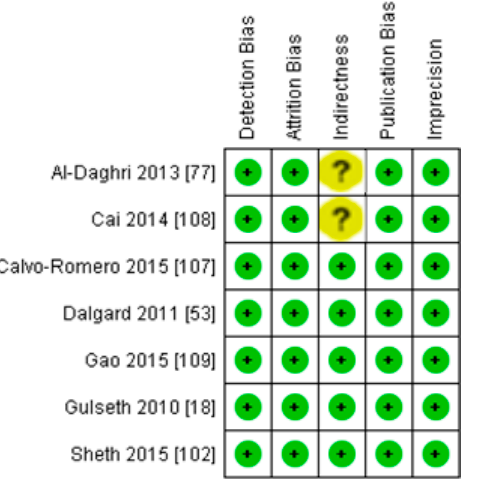
Nutrients 2021 , 13 , x FOR PEER REVIEW Figure 11. Meta regression analysis for diabetic subject studies. Latitude R 2 shows the effect of the moderator on the heterogeneity of correlation. ( a ) total variance in true effects; ( b ) not explained by model; ( c ) explained by model.